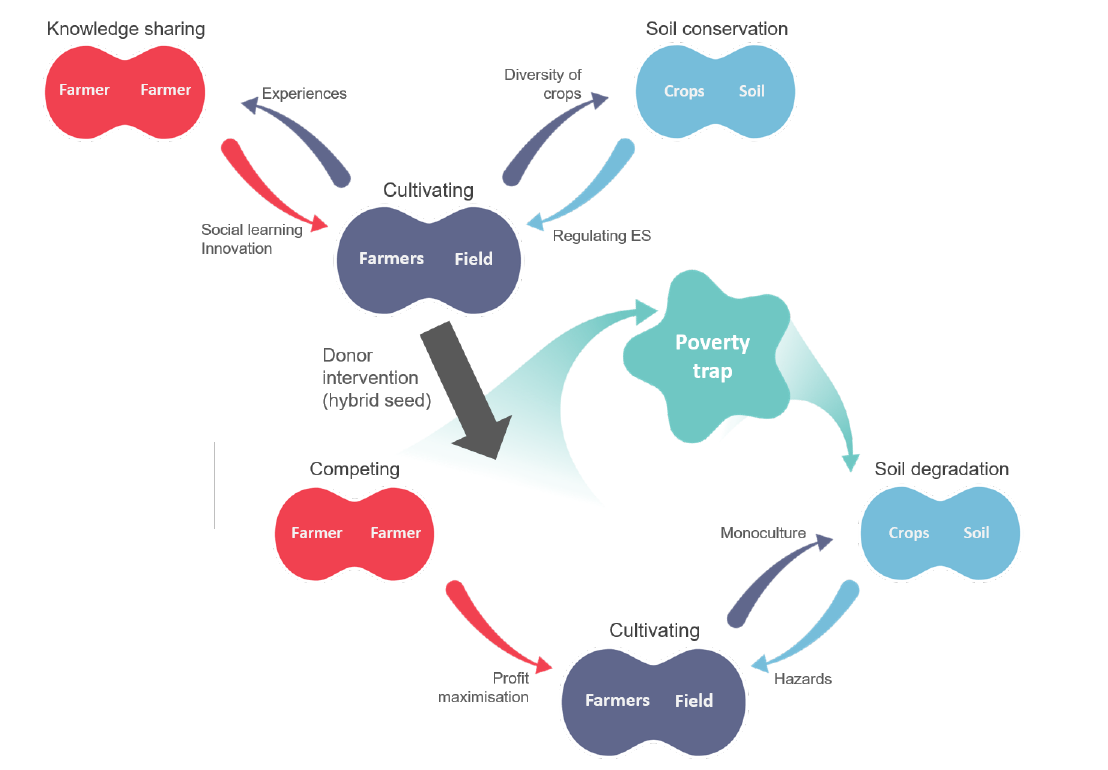
Fig. 4 . Social-ecological action situations (SE-AS) representation of the configuration of social-ecological (dark blue), ecological (light blue), and social (red) action situations hypothesized to generate a social- ecological trap and the loss of native seeds in the Pamir mountains. Traditional agriculture before development intervention (left) and after development intervention of improved seed varieties